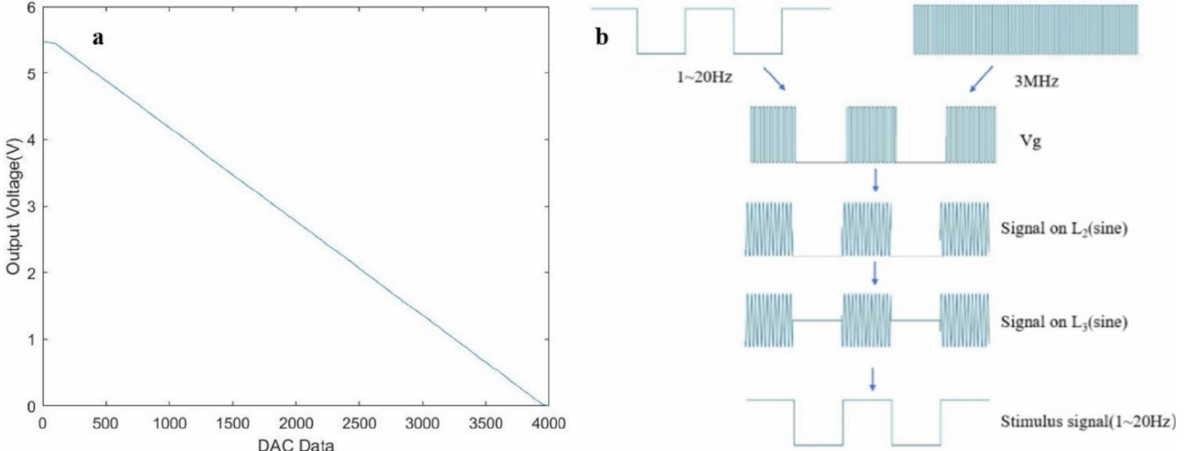
Figure 5. ( a ) The relationship between the DAC setting values and the output voltages; ( b ) The signal transmission process.